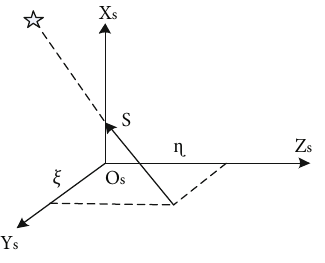
Figure 2: Representation of the stellar vector in the star sensor coordinate